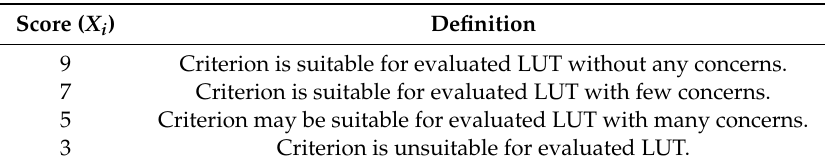
Table 5. Scale for scoring according to PRA method.